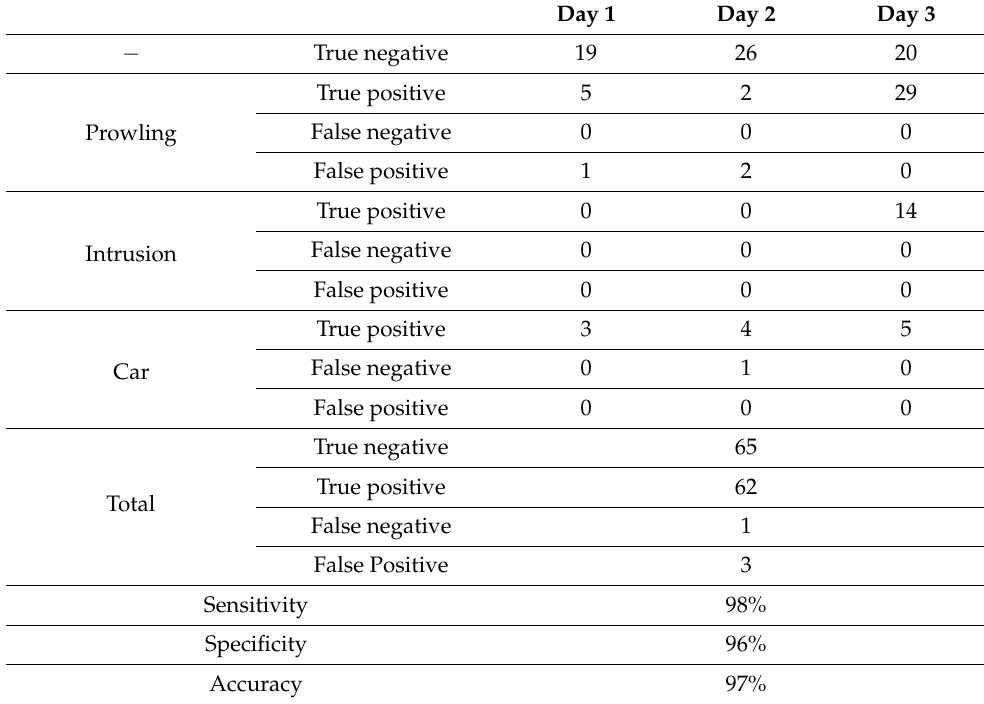
Table 2. Sensitivity and specificity of the CEMF